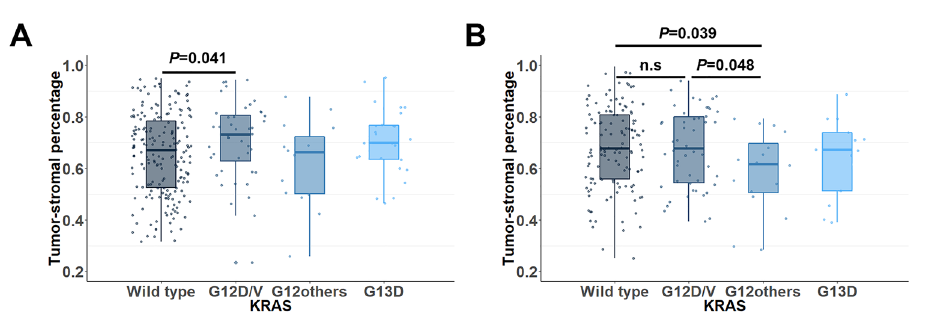
Figure 3. Tumor-stromal percentage according to the KRAS mutation status in the ( A ) discovery cohort and ( B ) validation